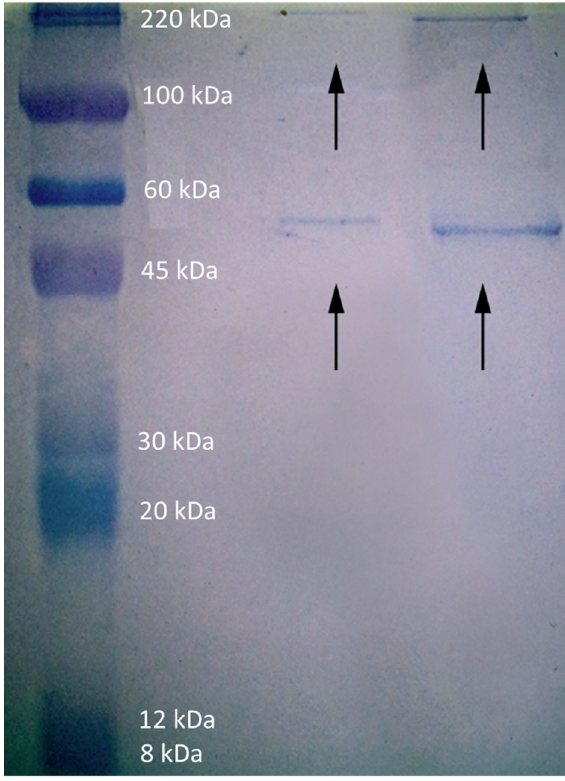
Figure 7. SDS ‐ PAGE gel (12.5%) obtained from nanoemulsion ‐ protein complexes after magnetic Figure 7. SDS-PAGE gel (12.5%) obtained from nanoemulsion-protein complexes after magnetic separation. The band on the left are the control separation. The band on the left are the control proteins.